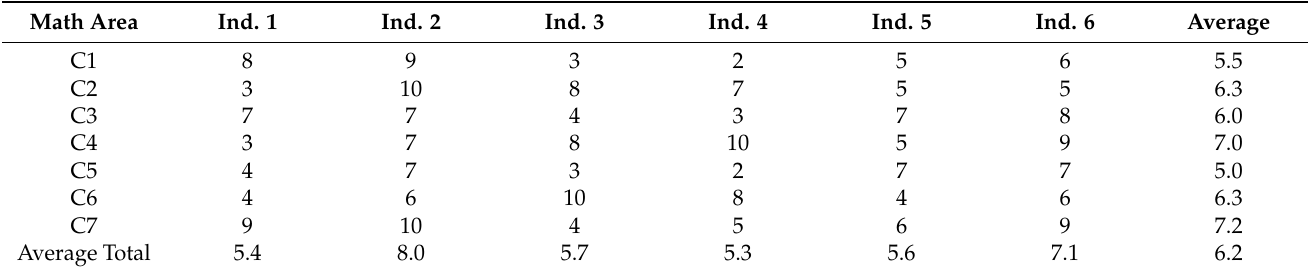
Table 2. Ranges and averages of the evaluation of the teaching of the numbers N, using a traditional teaching model.